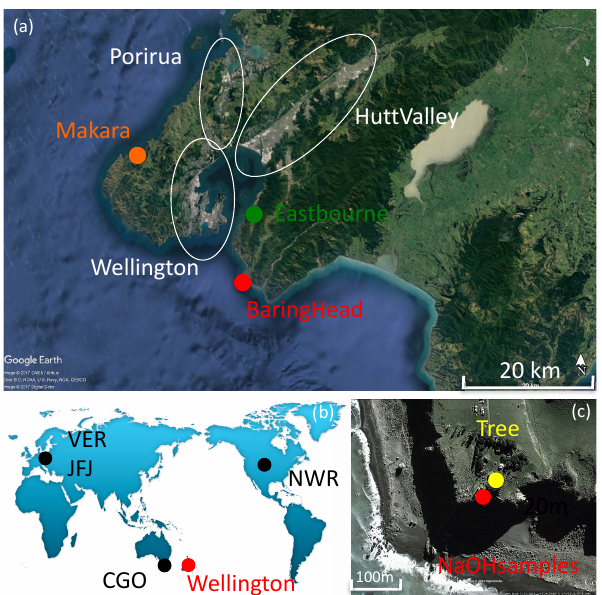
Figure 1. Sampling locations. (a) Makara (1954–1986) and Baring Head (1987–present) air sampling sites, the location of the East- bourne tree samples, and the urbanized areas of Wellington, Porirua and the Hutt Valley. (b) World location showing Wellington and other sampling sites discussed in the text. (c) Close-up of the Bar- ing Head site showing the relative positions of the air (NaOH) and tree sampling